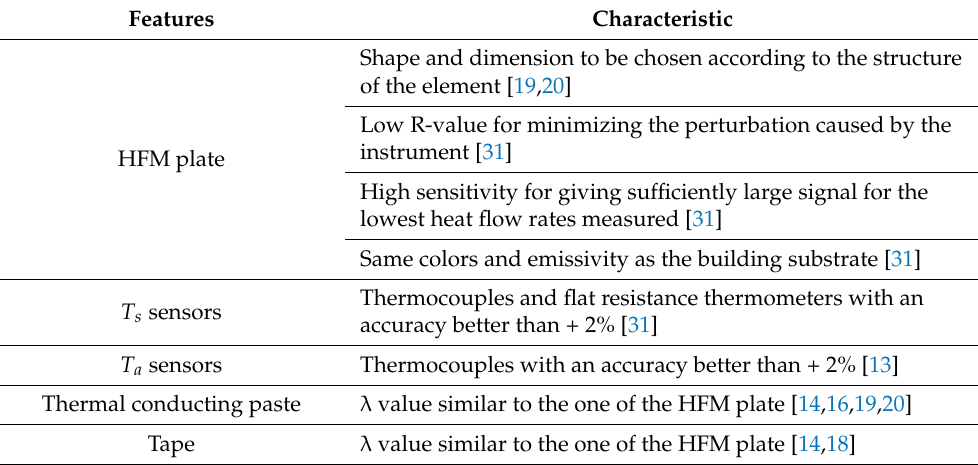
Table 5. Characteristics of the HFM apparatus (source: authors’ elaboration).